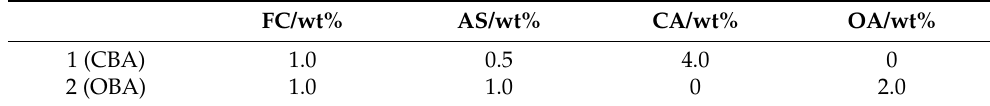
Table 2. Formulas of oil–displacement